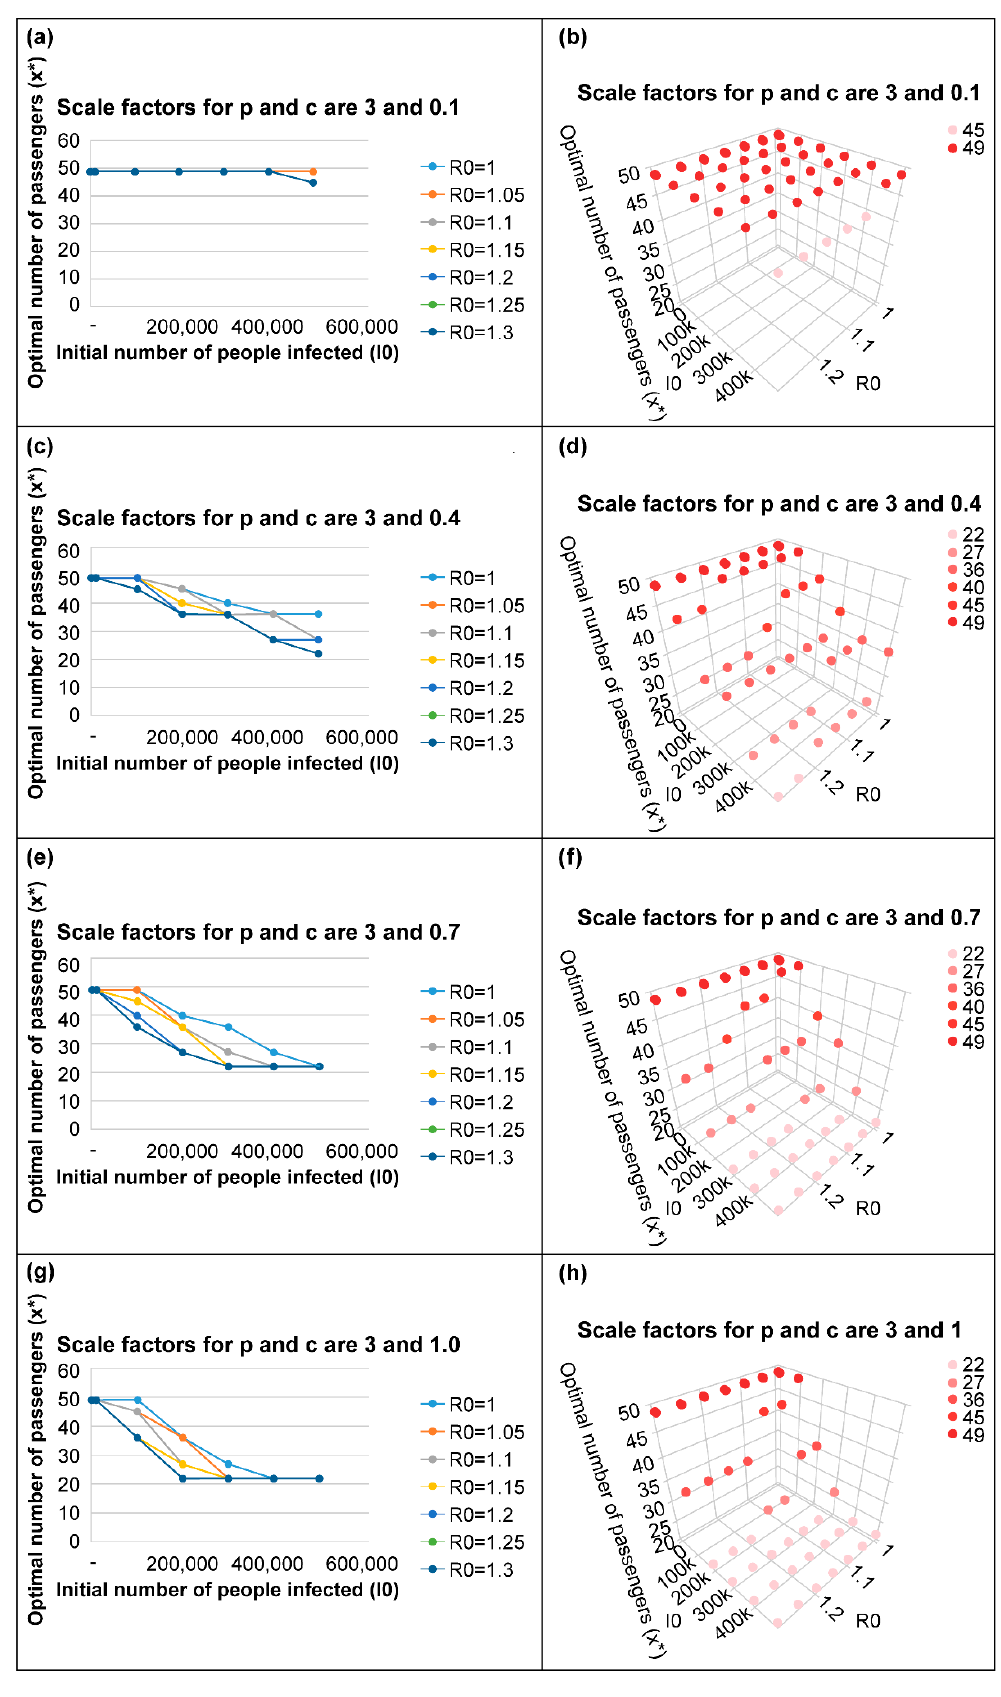
Figure 3. Optimal number of passengers to minimize total social cost when the scale factor for p is 3.